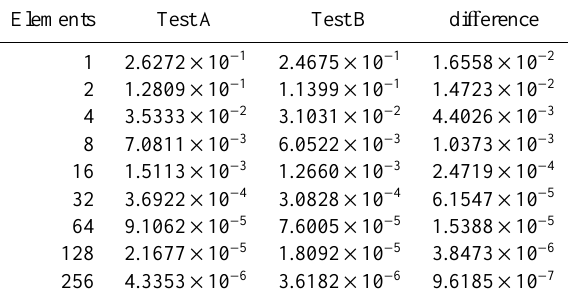
Table 7. Convergence Table Sect. 6.9. In the first column the num- ber of Finite Elements is displayed. The next two columns show the error of the Finite Element iterates compared the converged solu- − u ∗ | in Test A and Test B, whereas the third column tion | u FE A / B A / B − u FE | . As converged so- reports on the di ff erence of the iterates | u FE A B lution, the FE-solution for 512 Elements was used. The